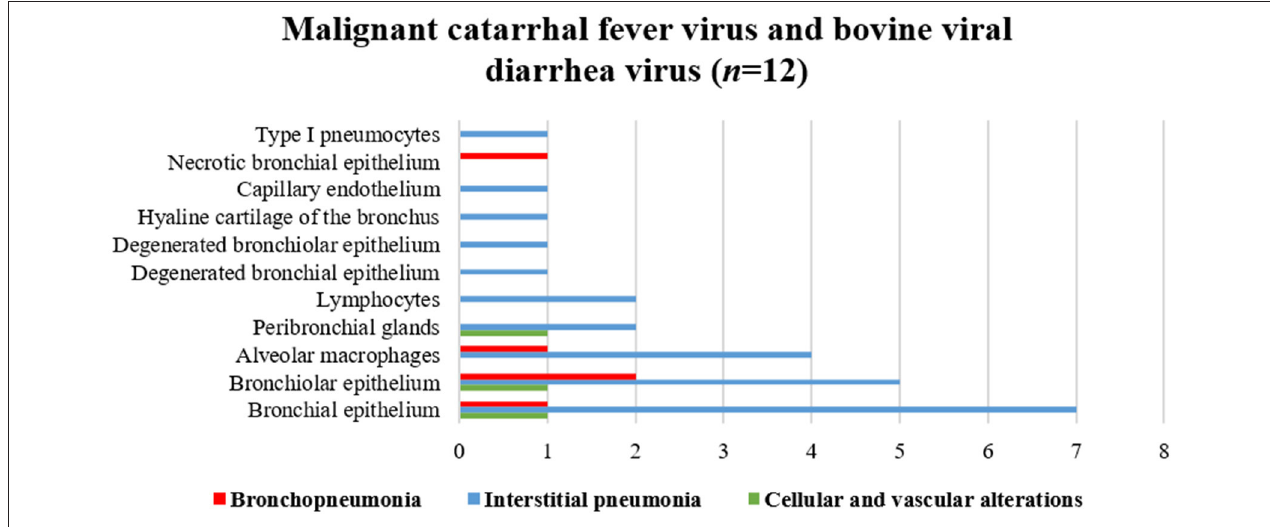
FIGURE 7 | Comparative demonstration of positive immunolabeling for MCFV and BVDV antigens within histologic elements of lungs of cattle with BRD.